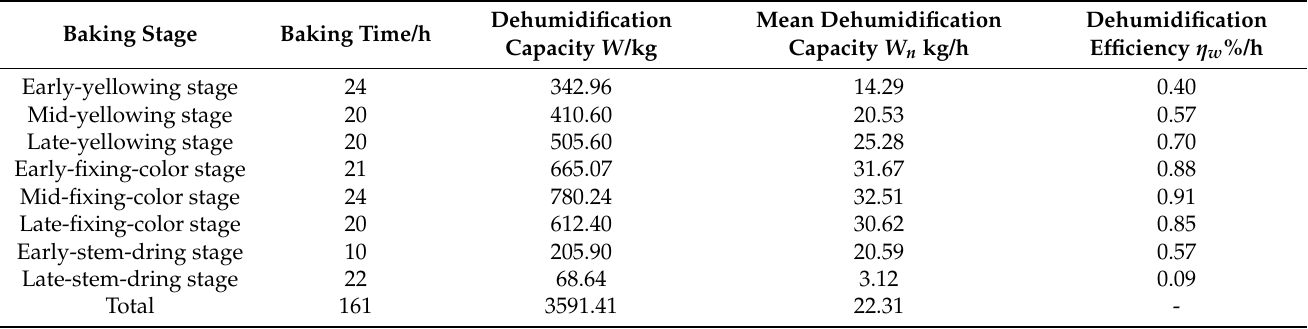
Table 6. The dehumidification capacity and efficiency in baking